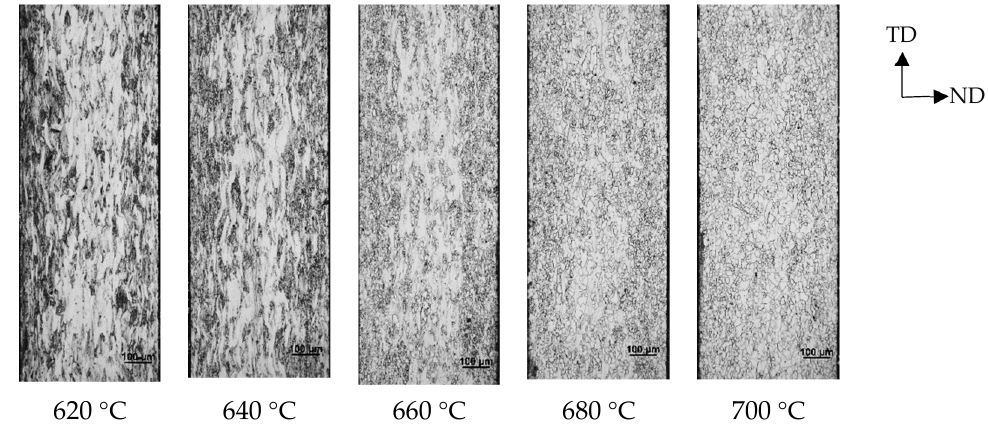
Figure 4. Microstructure of Fe-0.65%Si non-oriented electrical steel during recrystallization.